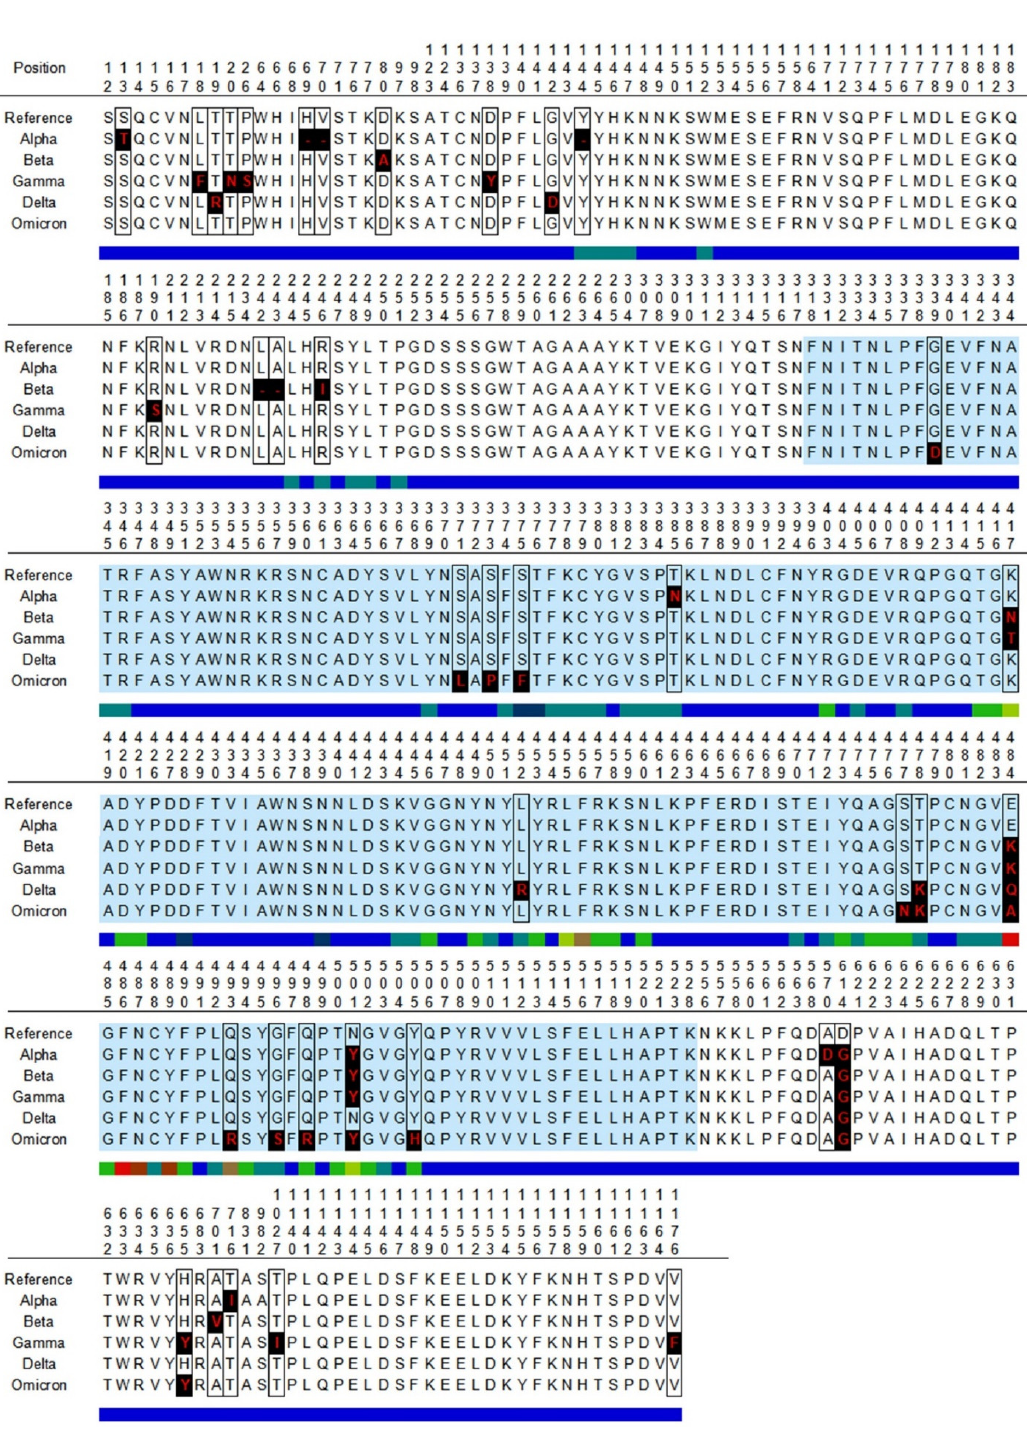
Figure 3. Spike glycoprotein residues recognized by neutralizing antibodies. A multiple sequence alignment of the spike glycoprotein from SARS-CoV-2 and variants of concern (VOCs) was generated and residues reported to be part of B cell epitopes recognized by neutralizing antibodies are shown. Spike residues that are mutated in SARS-CoV-2 VOCs are boxed and mutations highlighted. The receptor-binding domain (RBD) is shaded in cyan. Residue numbering is shown at the top. The bottom bar represents the occurrence of residues in B cell epitopes (1 to 99) in a color gradient from dark blue (1, at least in one B cell epitope) to green and then to bright red (top value is for E484 which is part of 99 B cell